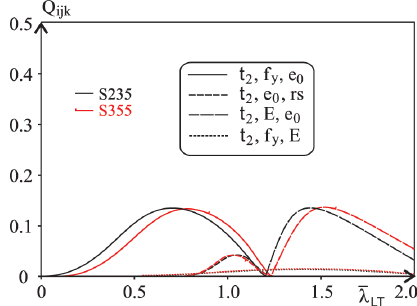
Figure 9. Third order quantile contrast indices 62×46 mm